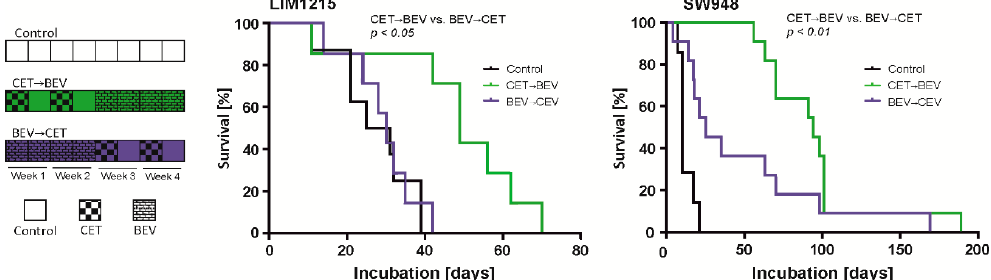
Figure 5. Impact of different treatment sequences on subcutaneous LIM1215 and SW948 tumor growth. Mice were treated either with PBS (control) for four weeks (two injections per week), with CET for two weeks followed by BEV for two weeks (CET->BEV) or with BEV for two weeks followed by CET for two weeks (BEV->CET). Tumor volume was measured at the indicated intervals (Lim1215 control: n = 8; CET->BEV, BEV->CET: n = 7; SW948 control: n = 7; CET->BEV, BEV->CET: n = 11). Growth data of each individual tumor are given in Figure S4.